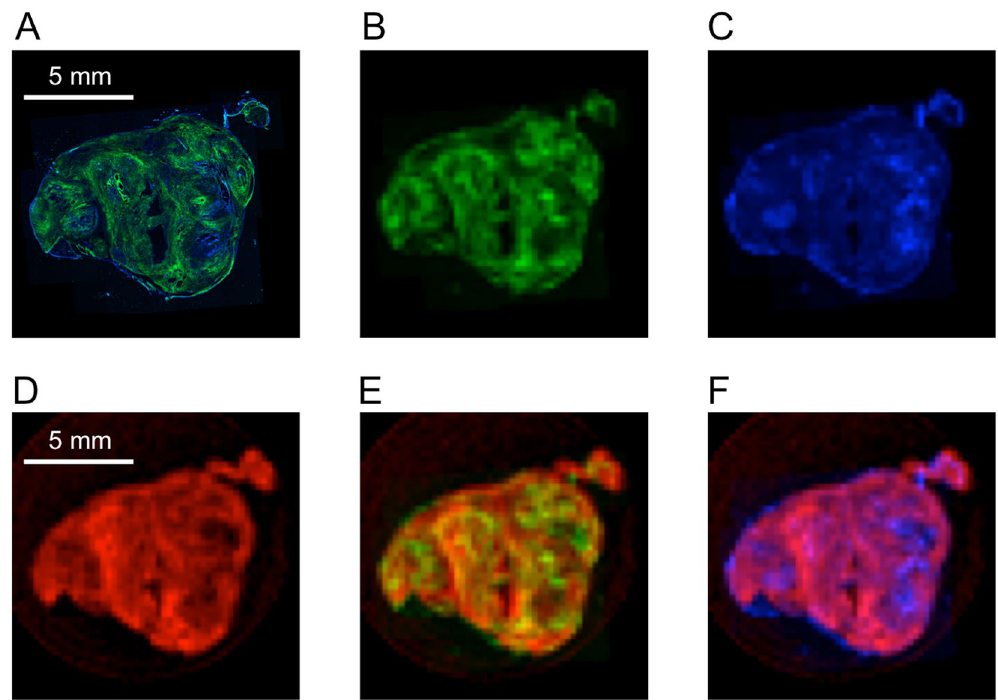
Figure 3. Comparison of two-photon microscopy autofluorescence and second harmonic generated (SHG) images with ex-vivo EP-3533 enhanced MR images of a tumour specimen. ( A ) High-resolution two-photon micrograph of a 30 μ m tumour slice showing overlay of SHG image of collagen (green) and autofluorescence (blue). ( B ) SHG collagen image rendered at the same resolution as ex-vivo MRI. ( C ) Autofluorescence rendered at the same resolution as ex-vivo MRI. ( D ) T1-weighted ex-vivo EP-3533 enhanced MR image (animal sacrificed 80 min post-injection) of the tumour slice matched to panels ( A – C ). ( E ) Image overlay of EP-3533 enhanced MRI (red) with SHG image of collagen (green). ( F ) Image overlay of EP-3533 enhanced MRI (red) with autofluorescence image Correlation between spatial distribution of collagen in PDAC and MRI enhanced with EP-3533.